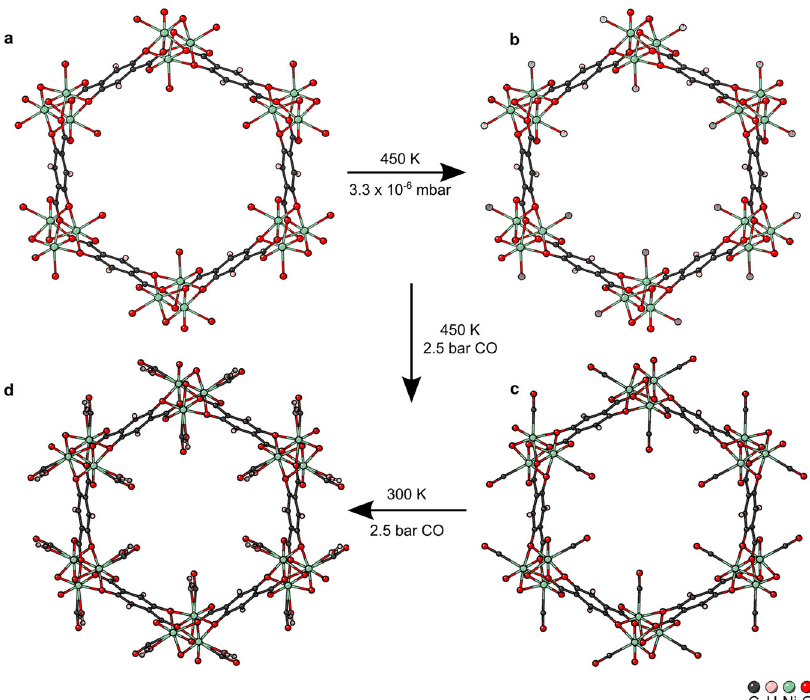
Fig. 1 Depictions of the crystal structure of Ni-CPO-27 along the crystallographic c -axis under different gas loading conditions. The framework is shown with 40% space fi lling spheres. a Hydrated structure at room temperature and ambient pressure. b Activated structure at 450 K and 3.3 × 10 − 6 mbar, with 6.06(2)% water occupancy, which is considered activated, CCDC number: 2208832. c CO loaded structure at 450 K and 2.5 bar CO pressure, with 38(3)% CO occupancy, CCDC number: 2208829. d CO loaded structure at 300 K and 2.5 bar CO pressure, with 63(4)% CO occupancy, and 27(3)% water occupancy, CCDC number: